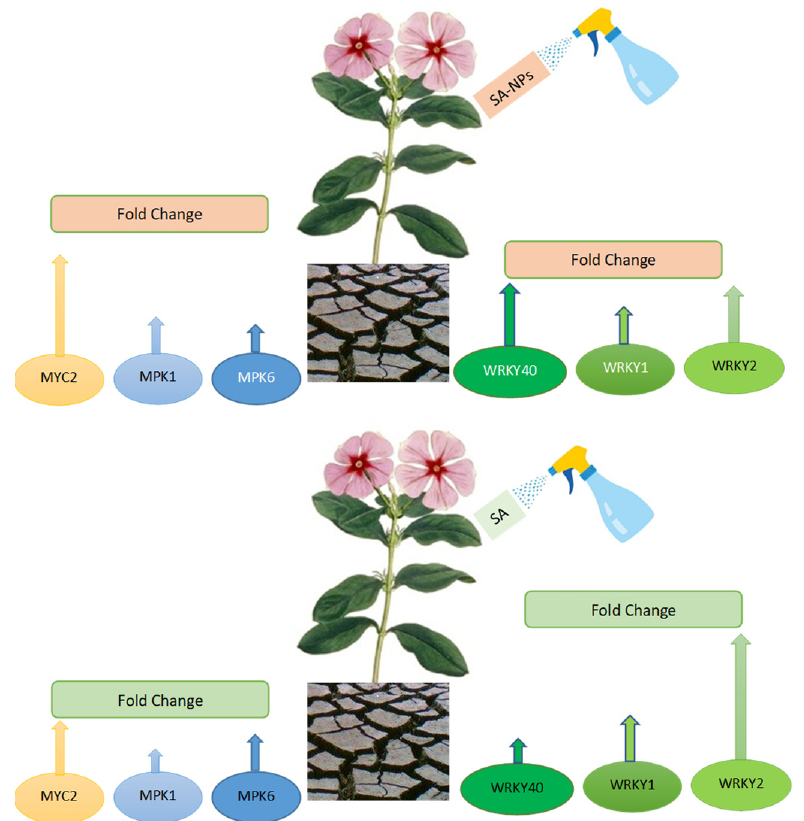
Figure 6. Schematic diagram of drought stress, exogenous application with SA and SANPs, and genetic response for Catharanthus roseus plants.